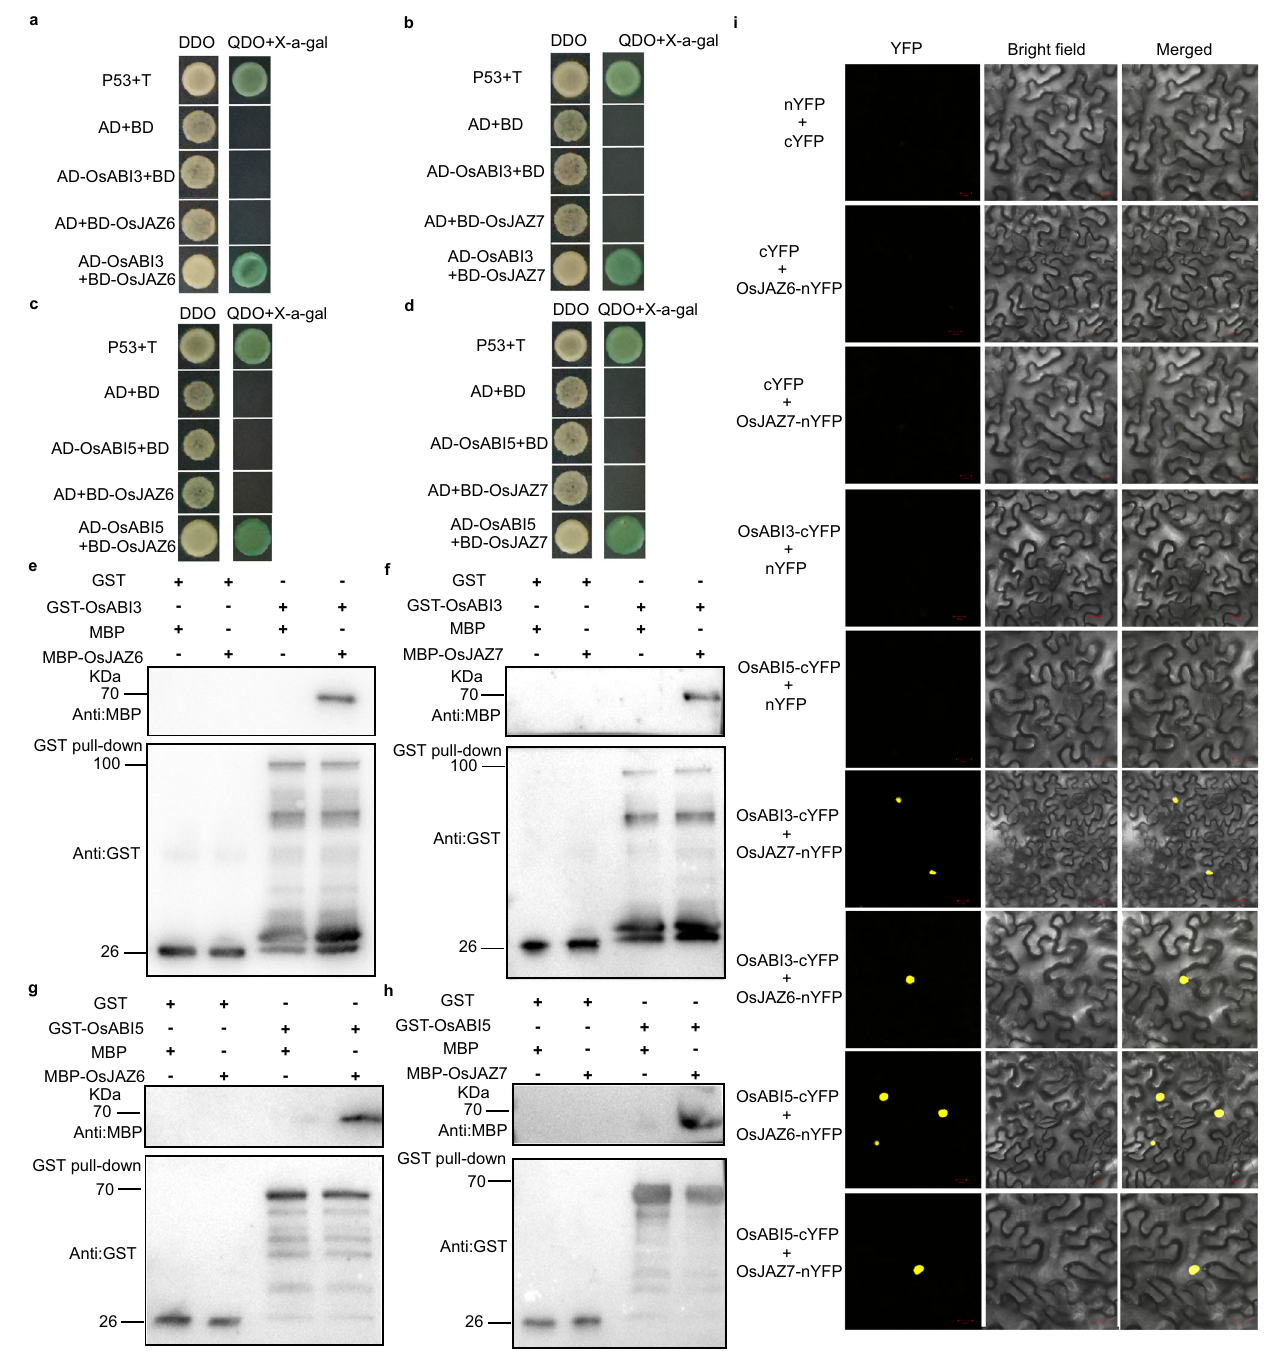
Fig. 5 | In vitro and in vivo interaction assays between OsJAZs and OsABIs. a – d Yeast-two-hybrid (Y2H) analysis revealed interactions between OsABI3/5 and OsJAZ6/7. Transformed yeast cells were grown on SD-Trp/-His/-Leu/-Ade medium. e – h In vitropull-downassays revealed interactions betweenOsABI3/5andOsJAZ6/ 7. n =3 independent experiments. i Bimolecular fl uorescence complementation analysis of the interactions between OsABI3/5 and OsJAZ6/7. n =3 biologically